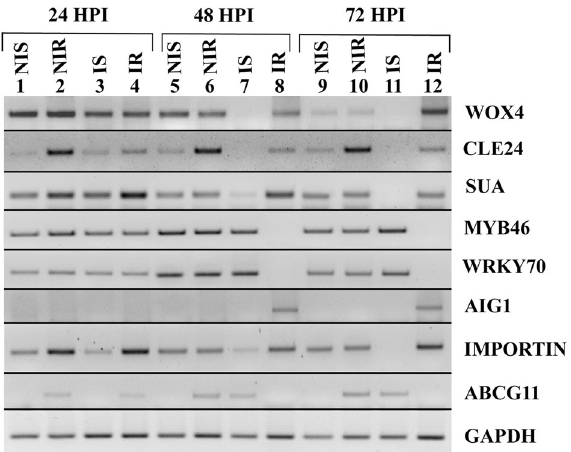
Figure 4. Semi-quantitative reverse-transcriptase PCR amplification patterns of selected genes in the control and Fusarium udum inoculated susceptible ICP 2376 and resistant ICP 8863 pigeonpea cultivars at three different time points in 2% agarose gel. Lanes 1, 5 and 9: TDFs derived from non-inoculated susceptible ICP 2376 (NIS) at 24, 48 and 72 h post inoculation (HPI), respectively; 2, 6 and 10: TDFs derived from non- inoculated resistant ICP 8863 (NIR) at 24, 48 and 72 HPI, respectively; 3, 7 and 11: TDFs derived from infected susceptible (IS) at 24, 48 and 72 HPI, respectively; 4, 8 and 12: TDFs derived from infected resistant (IR) at 24, 48 and 72 HPI, respectively. ABCG11 ABC transporter G family member 11, AIG1 avrRpt2 induced gene 1, CLE24 CLAVATA3/ESR-related 24, GAPDH glyceraldehyde 3-phosphate dehydrogenase, IMPORTIN importin subunit beta-1, MYB46 transcription factor MYB46, SUA SUPPRESSOR OF ABI3-5, WOX4 WUSCHEL-related homeobox 4, WRKY70 WRKY transcription factor